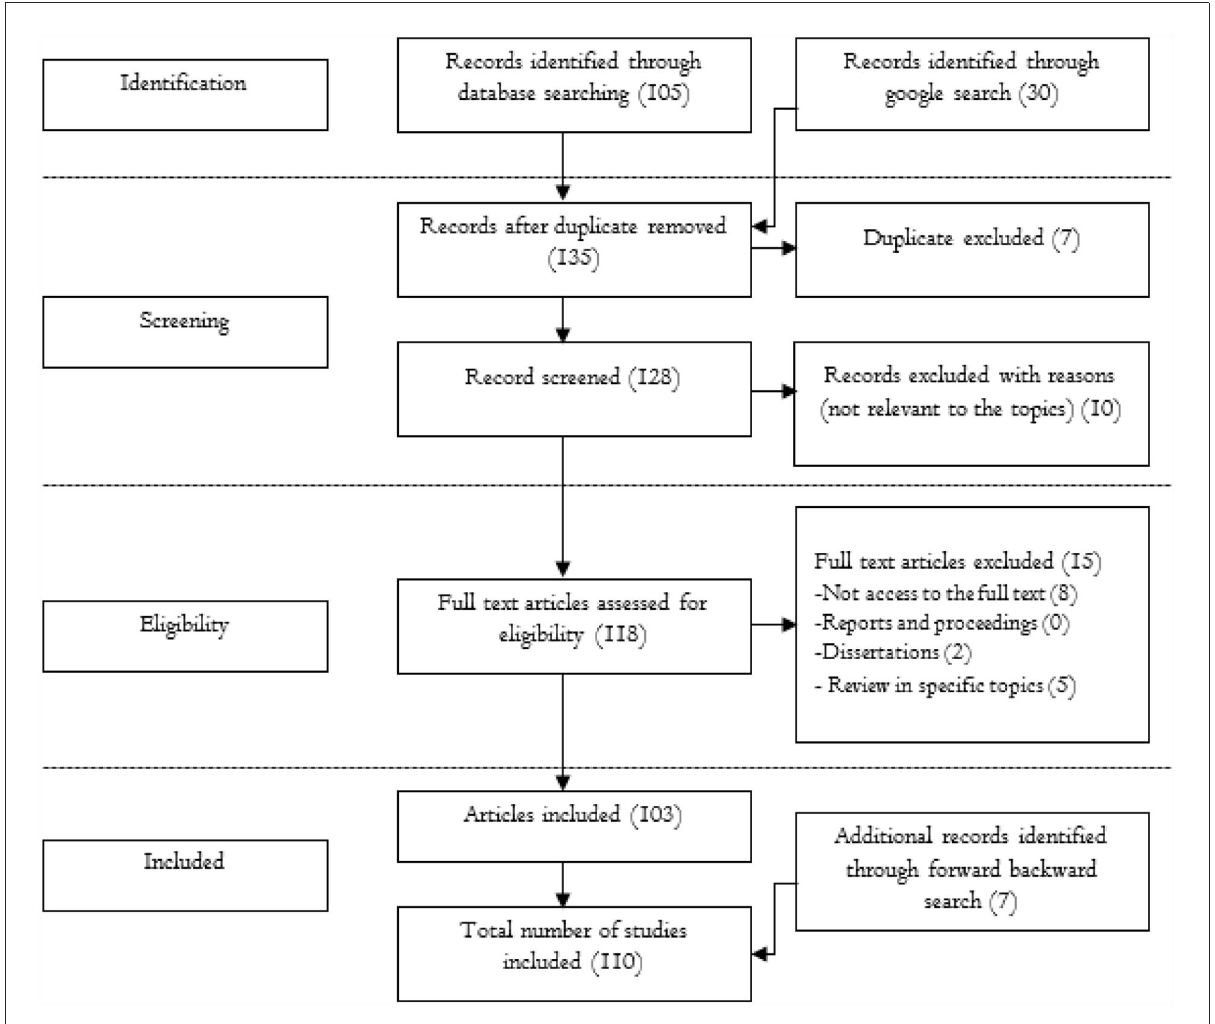
FIGURE1 Literature search and evaluation process and decision making for inclusion.